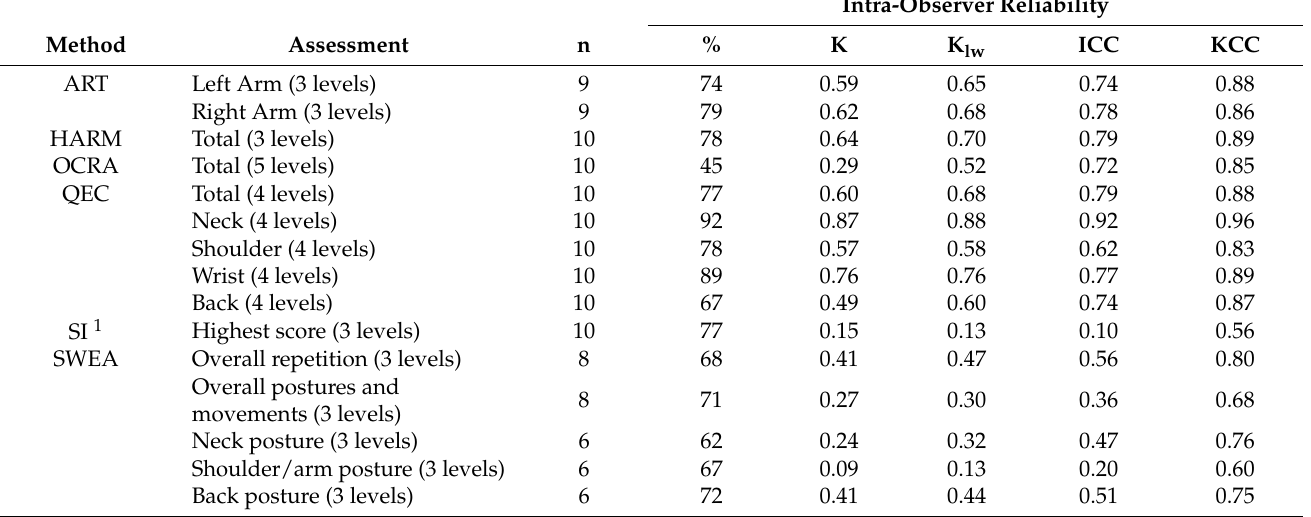
Table 7. Intra-observer reliability of risk levels, with pre-given specific differing work task durations for the ten work tasks (See Table 2). Number of ergonomists (n), proportional agreement (%) mean Cohens kappa (K), linearly weighted kappa averaged over pairs (K lw ), intraclass correlation (ICC) and Kendall’s coefficient of concordance (KCC) for the results of the ergonomists’ ratings of the ten different video-recorded work tasks. The ratings were first used to compute the score for each method and then converted into risk levels.